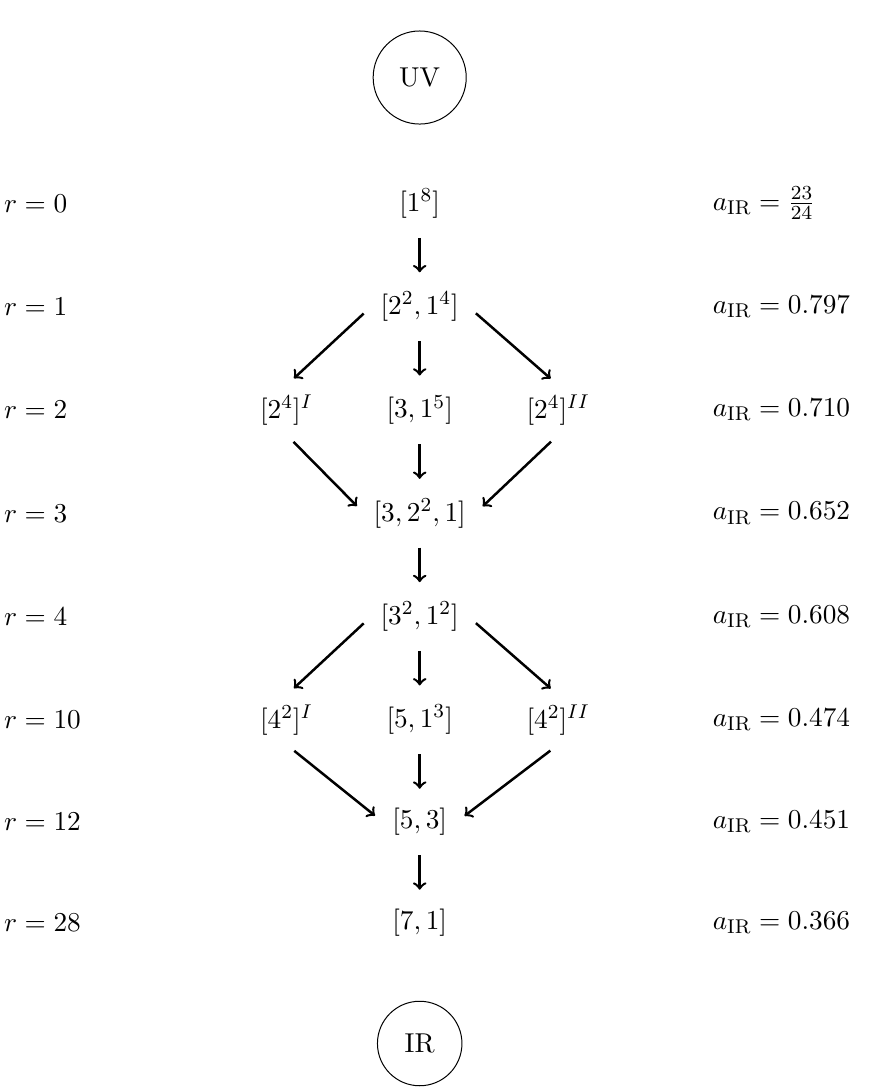
Figure 3. The network of RG (cid:13)ows induced by nilpotent plain mass deformations for N = 2 Super Yang-Mills with SU(2) gauge group and four (cid:13)avors. This theory has an SO(8) (cid:13)avor symmetry in the UV. This network is identical to the Hasse diagram of the Lie algebra so (8). The parameter r = 2Tr ( T 3 T 3 ) is the embedding index for the homomorphism su (2) ! so (8) de(cid:12)ned by a so (8) nilpotent orbit. The value of the conformal anomaly a IR decreases, as expected. These (cid:13)ows are determined using the method described in sections 3 and